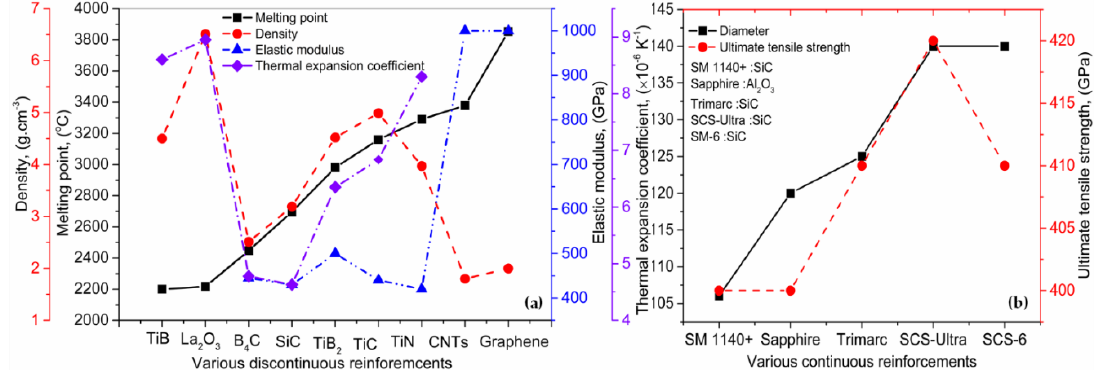
Figure 9. Properties of various TMCs ( a ) discontinuous and ( b ) continuous reinforcements; based on the data provided in Ref. [104].